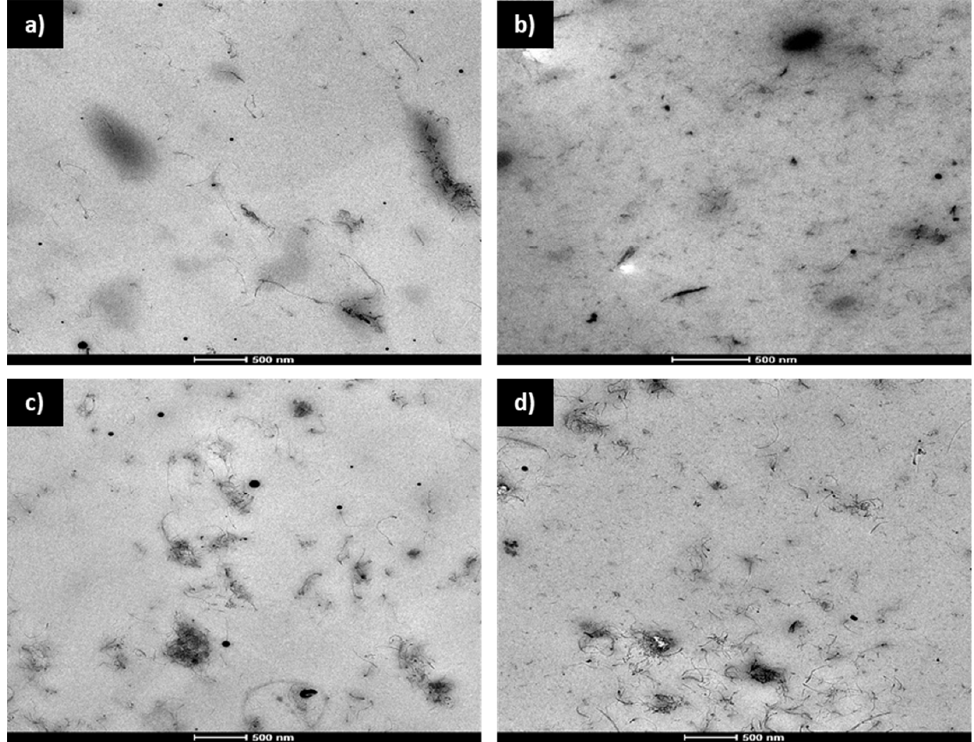
Figure 1. Transmission Electron Micrographs (TEM) from DL:EB samples of 0.5% CNTs ( a ) and 1% CNTs ( c ); and L:EB samples of 0.5% CNTs ( b ) and 1% CNTs ( d ) .